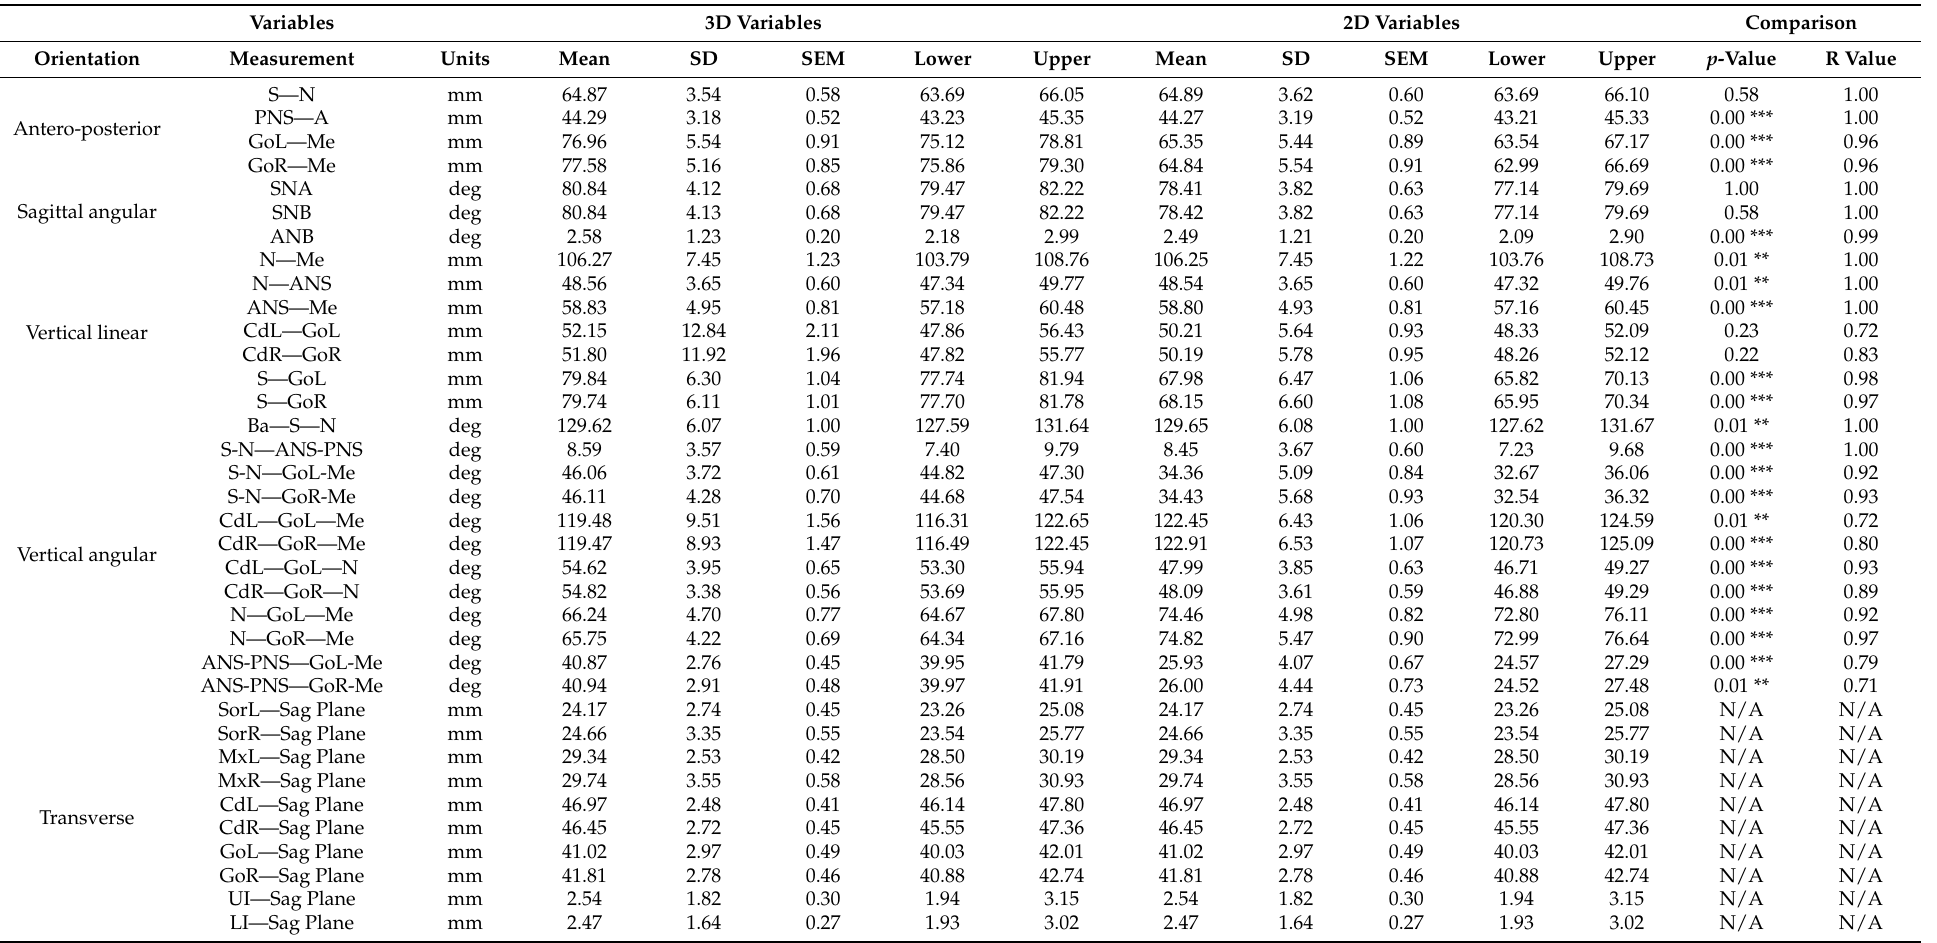
Table 3. Descriptive statistics (mean, standard deviation (SD), SEM, and 95% confidence interval (CI) lower and higher) of the 3D and 2D cephalometric measurements and their comparisons (Pearson correlation coefficient R and p -value) for the peak age subgroup. Confidence interval (CI), lower (L), upper (U) limits; p -values and relevant correlation coefficients are computed by the Pearson correlation analysis; not computed (n/a) statistical significance